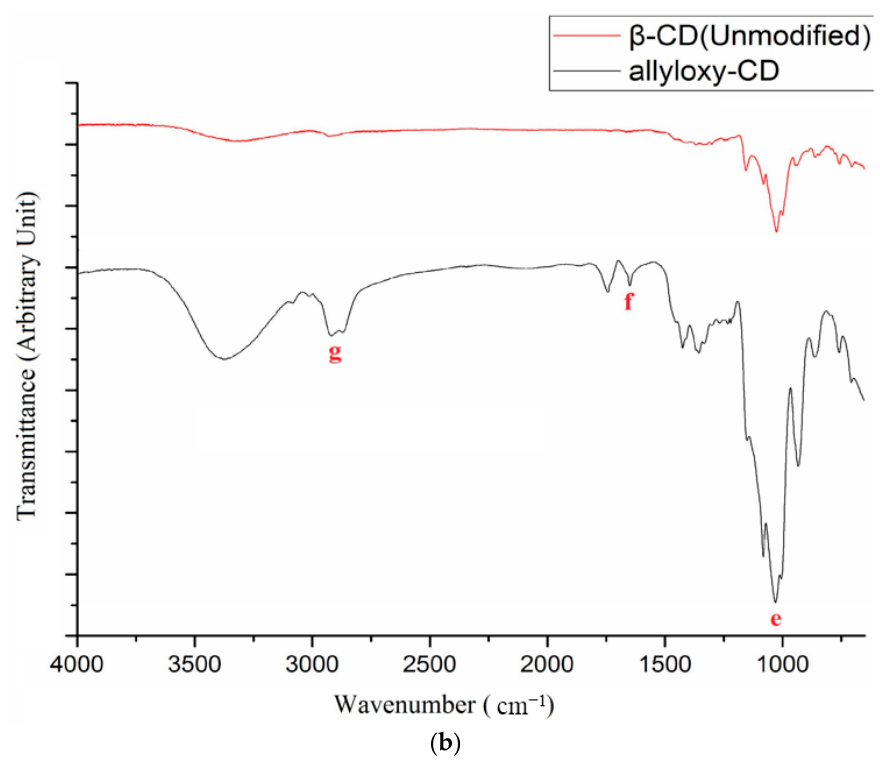
Figure 2. ( a ) 1 H-nuclear magnetic resonance ( 1 H-NMR) spectrum of allyloxy-CD; and ( b ) Fourier transform infrared (FTIR) spectra of unmodified β -CD and allyloxy-CD.